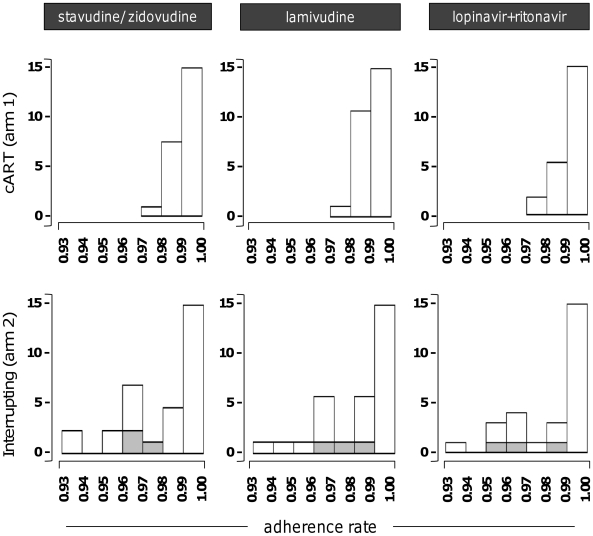
Treatment adherence.Adherence to individual ART regimen components (indicated) was calculated as specified in the text, and is represented in the form of adherence rate class distribution (from 0.93 to 1%) for the cART arm (top panels) and the intermittent ART arm (bottom panels). The contribution of the 3 individuals that failed to re-suppress to HIV RNA<50 copies/ml within 12 weeks from ART resumption is indicated as filled stacked bars.